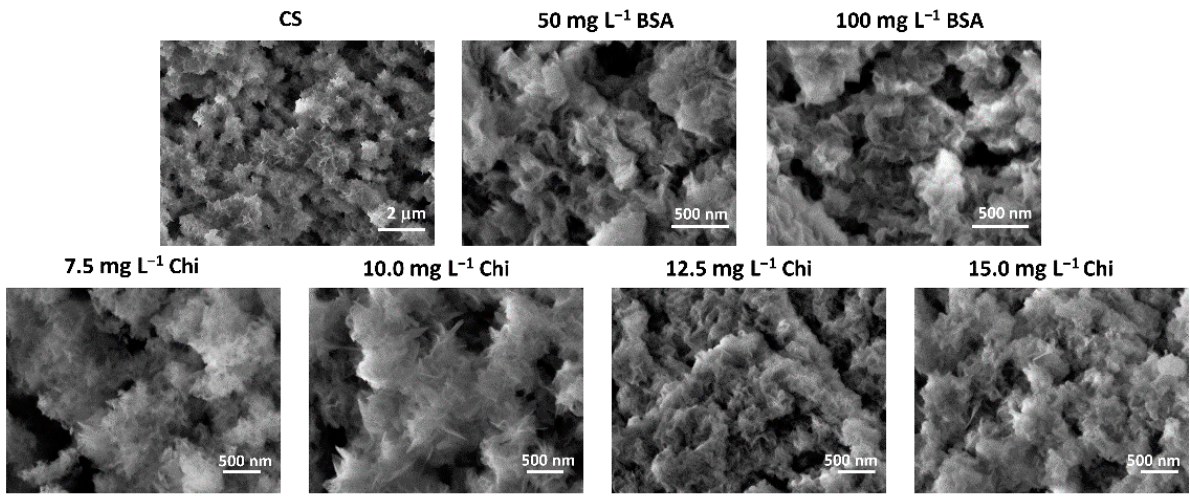
Figure 7. SEM micrographs of the precipitates obtained in the control system (CS) and in the presence of different concentrations of bovine serum albumin (BSA) after 60 min and chitosan (Chi) after 120 min. c (CaCl 2 ) = c (Na 2 HPO 4 ) = 4 × 10 − 3 mol dm − 3 , pH init = 7.4, ϑ = (25 ± 0.1) °C.